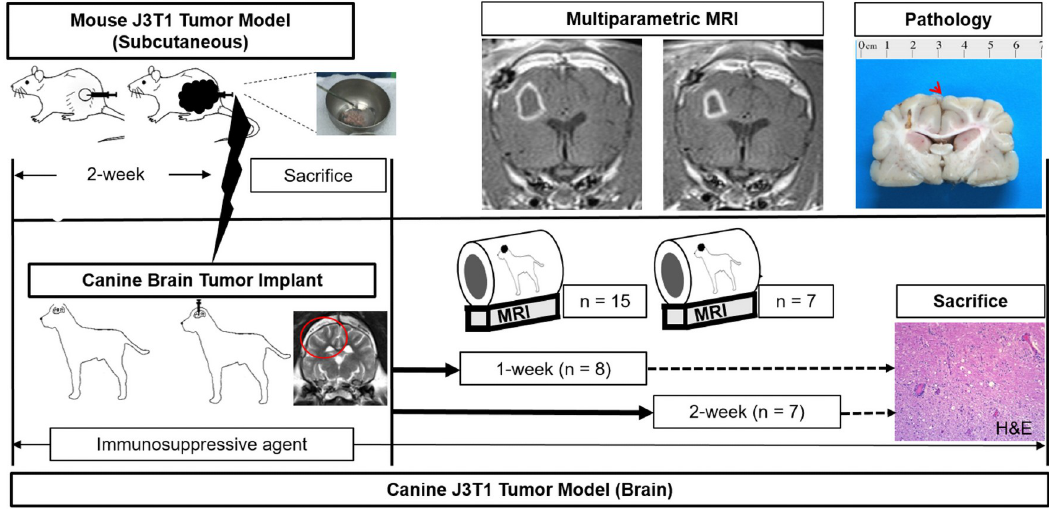
Fig 1. Experimental design. J3T1 cells were subcutaneously injected into the flank area of BALB/c nude mice. After two weeks, the mice were sacrificed to obtain viable tumour fragments. Preimplantation, dogs were treated with immunosuppressive agents for two weeks, and tumour fragments from the mice were injected into the right frontoparietal region of the brain parenchyma. After one week, postimplantation MRI with diffusion-weighted and perfusion-weighted imaging was performed every week until sacrifice. Immunosuppressive agents were also administered to the implanted dogs until sacrifice. Fifteen canine models were successfully created, and brain images from eight and seven subjects were obtained at 1 week and 2 weeks, respectively. After the follow-up imaging study, the brains were extracted for histological